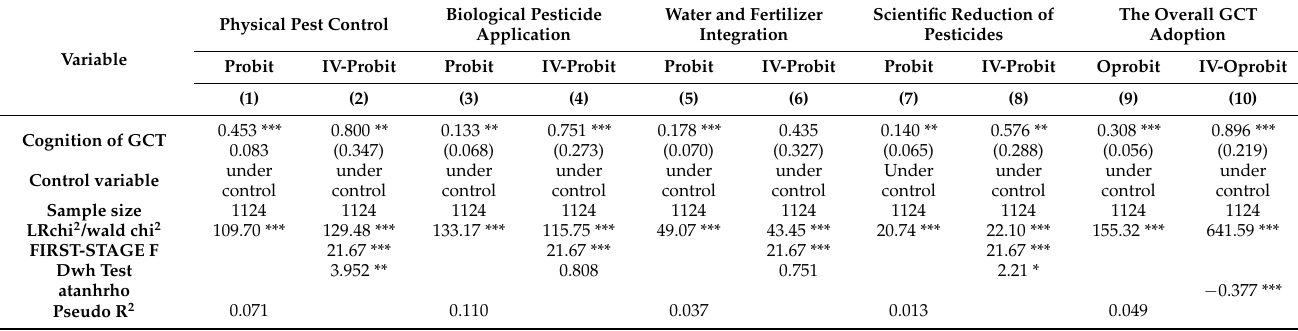
Table 5. Effect of green prevention and control cognition on GCT